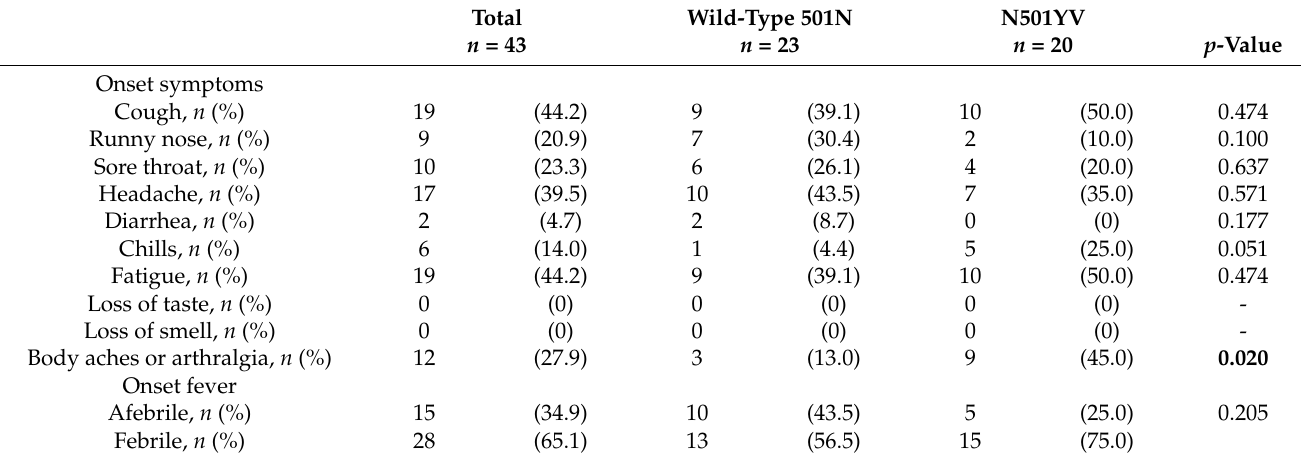
Table 2. Onset symptoms of the patients infected with wild-type 501N and N501YV. ( n = 43 *).